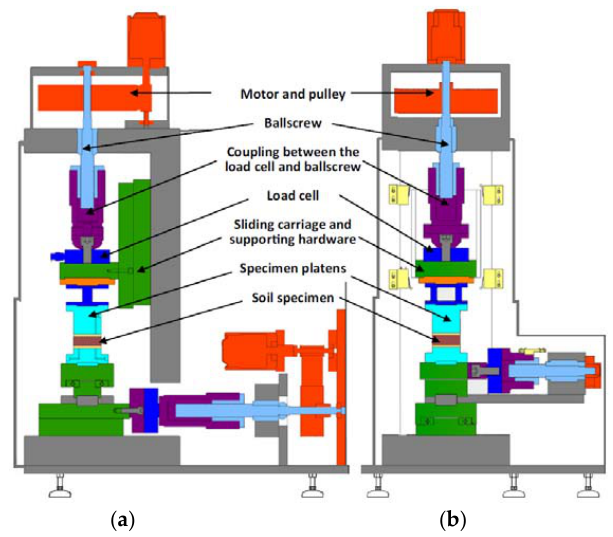
Figure 1. Schematic of a bi ‐ directional simple shear testing apparatus ( a ) YZ plane ( b ) XZ plane [52].